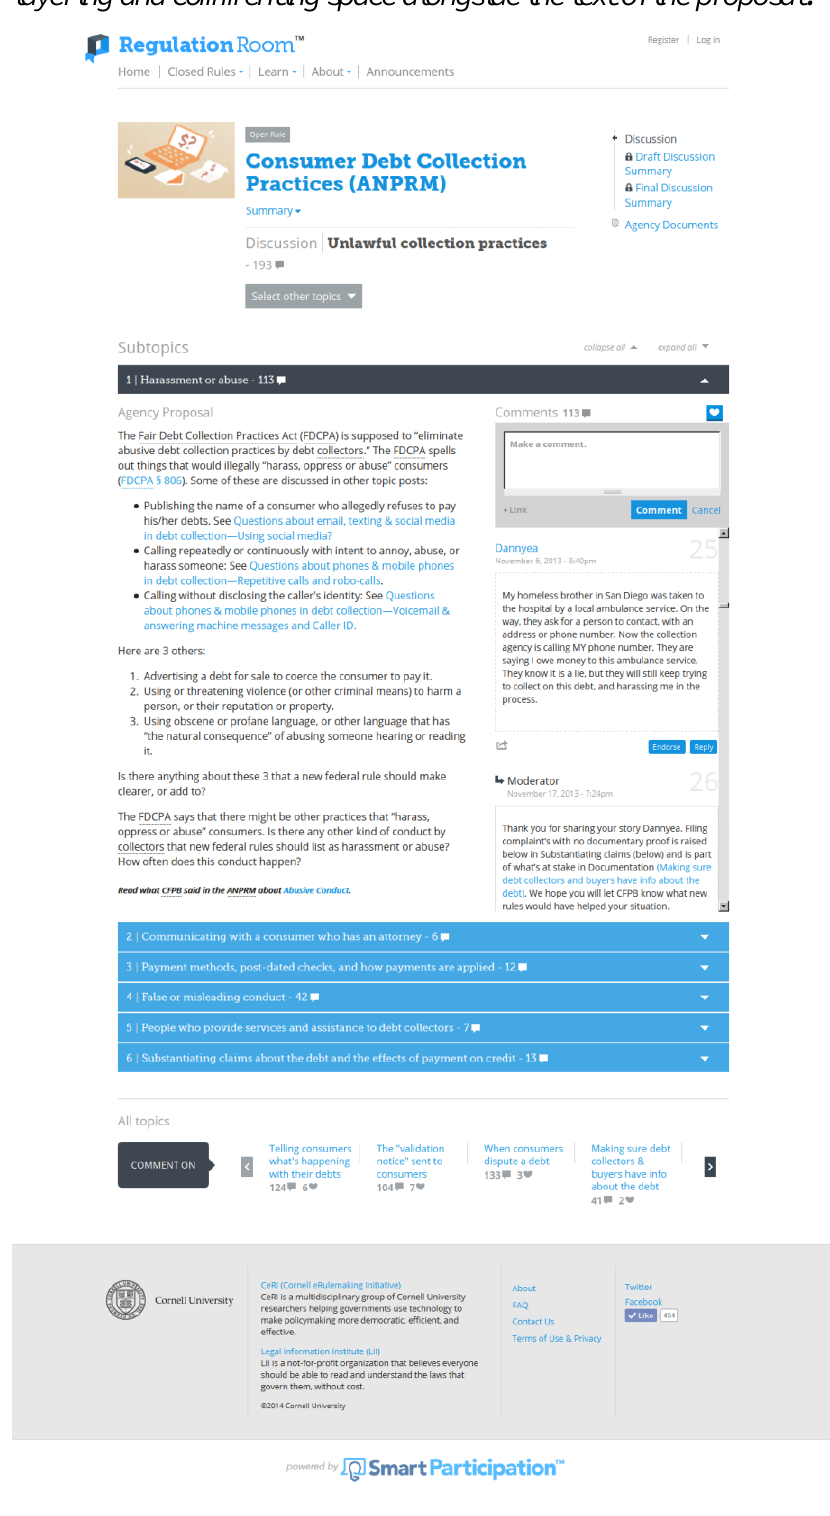
Figure 1 : Screenshot of a RegulationRoom topic post showing information layering and commenting space alongside the text of the